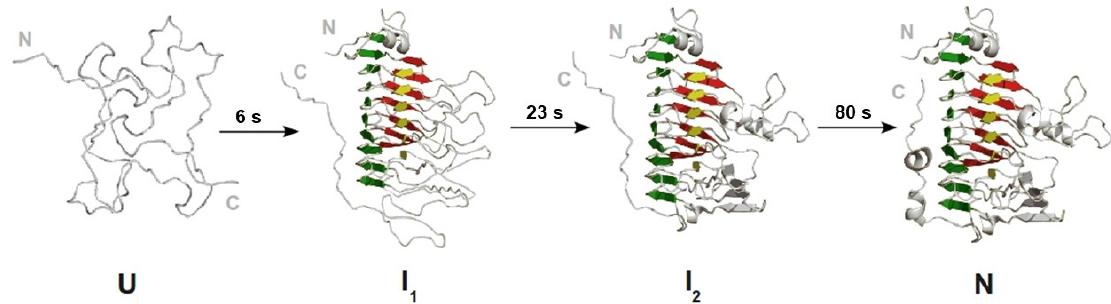
Figure 10. Representation of a possible folding pathway of PemA (pH 7, 25 °C). The sequential nature of the refolding process is indicated, and the two major intermediates are illustrated. The three β -sheets are in yellow (PB1), green (PB2), and red (PB3), and the N - and C -terminal ends of the polypeptide chain are indicated by N and C, respectively. Starting from a highly heterogeneous denatured state (U), the process of collapse (burst phase) and further minor structural rearrangements (phases 1 and 2) leads to a first intermediate species (I 1 ), with native-like structure in the entire β -helix domain but unstructured peripheral loops (see text for details). This is followed by the folding of most of the peripheral loops and the formation of a second intermediate species (I 2 ). Finally, the folding of the C -terminal loop and its docking against the parallel β -helix (PB2) (phase 4) leads to the final native structure. The values of the time constants for each step are indicated. Note that the various states in the model need to be described in terms of ensembles of conformers, and the experimental parameters are averaged over these